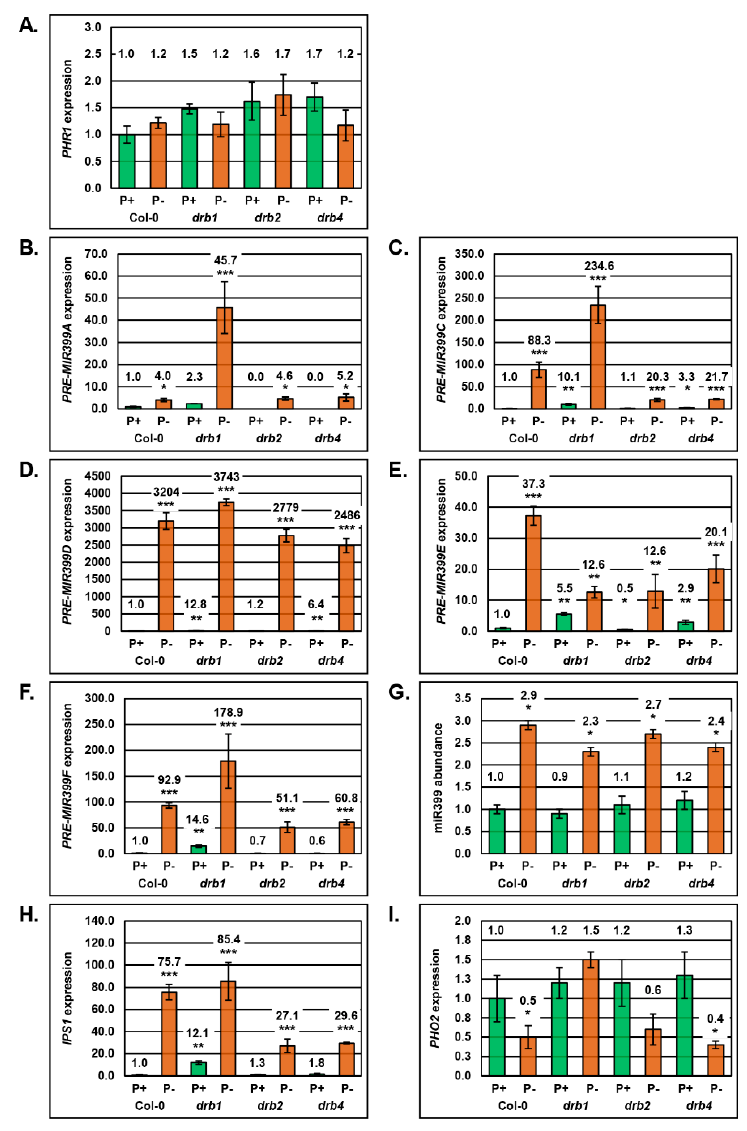
Figure 2. Molecular profiling of the miR399/ PHO2 expression module in the aerial tissues of non-stressed and PO 4 -stressed Col-0, drb1 , drb2 and drb4 plants. ( A ) RT-qPCR assessment of the expression of the PO 4 responsive transcription factor PHR1 in the aerial tissues of non-stressed and PO 4 -stressed Col-0, drb1 , drb2 and drb4 plants. ( B to F ) RT-qPCR profiling of miR399 precursor transcript abundance in the aerial tissues of non-stressed and PO 4 -stressed Col-0, drb1 , drb2 and drb4 plants, including